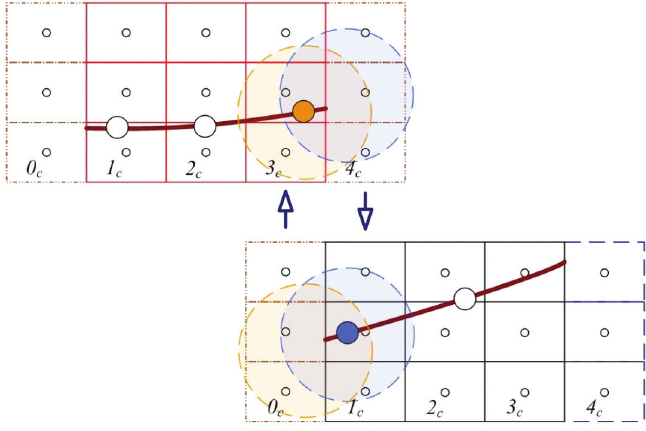
Figure 5 - Correct distribution of Lagrangian forces in a parallel approach. Step